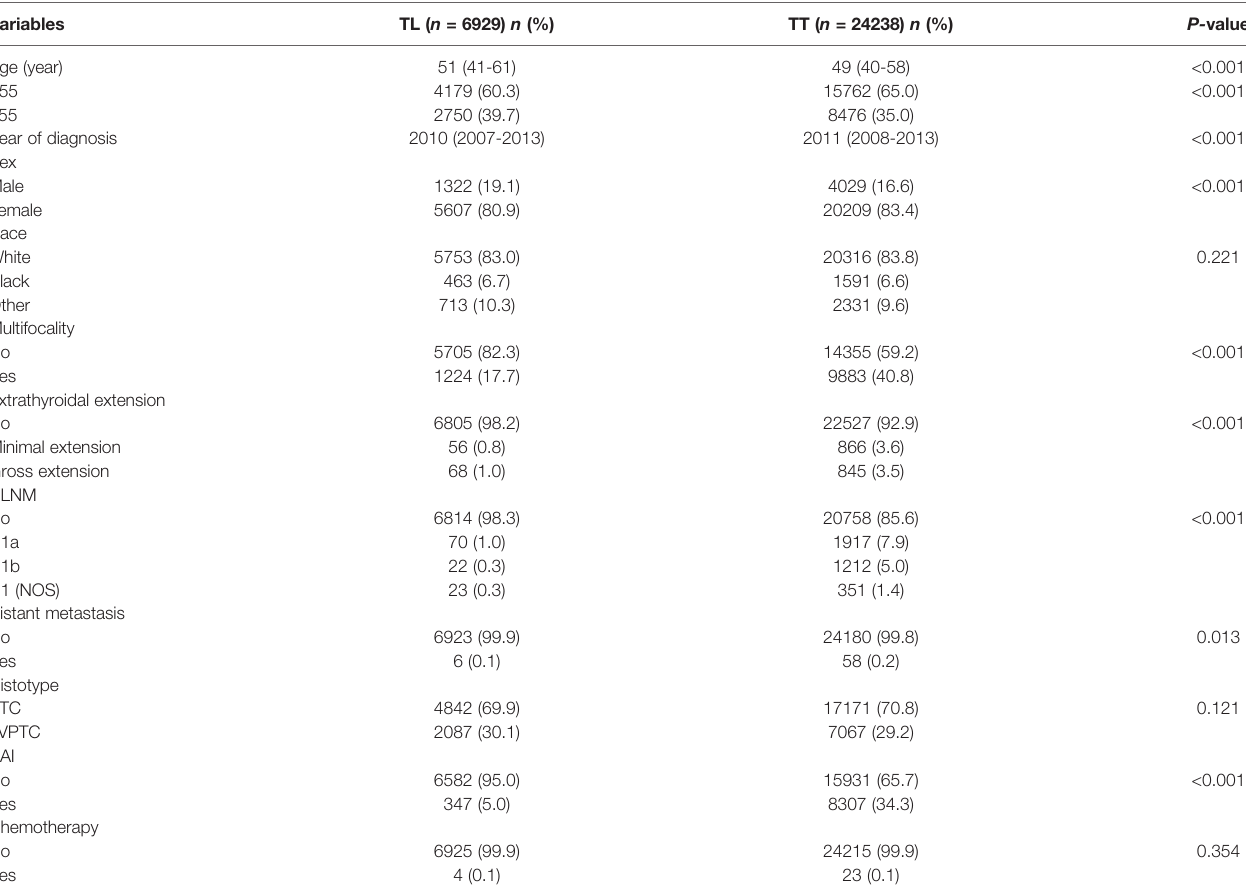
TABLE 1 | The clinicopathologic features of PTMC patients treated with TL versus TT.